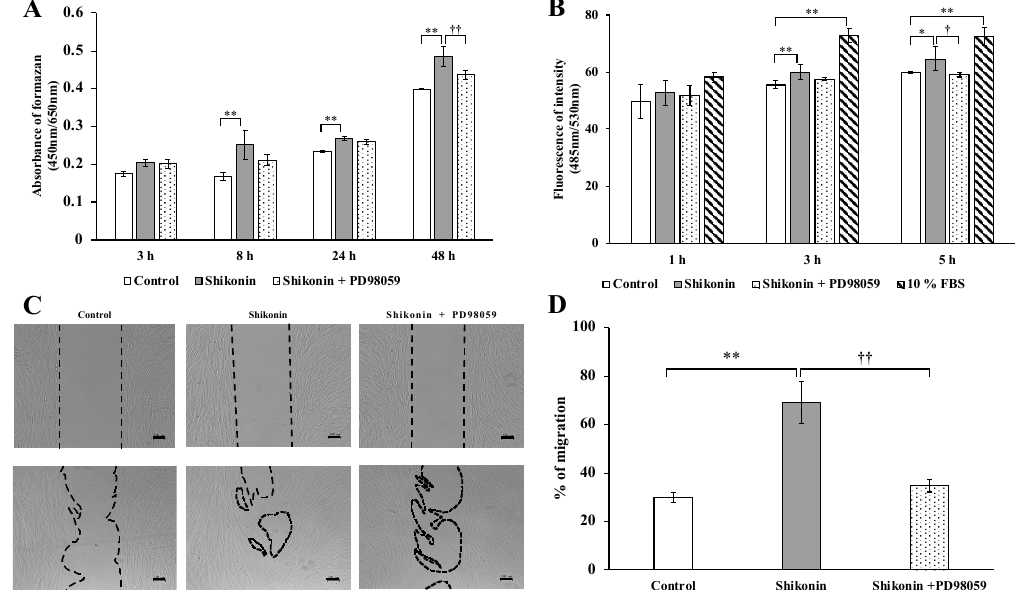
Figure 5. Effects of PD98059 on shikonin-stimulated human gingival fibroblast (hGF) cell proliferation and migration and wound repair. Treatment with 20 µ M PD98059 reduced 1 µ M shikonin-stimulated hGF ( A ) proliferation and ( B ) migration. ( C ) Images of wound repair and ( D ) quantitative data for wound repair. (* p < 0.05, control vs. 1 µ M shikonin; ** p < 0.01, control vs. 1 µ M shikonin; † p < 0.05, 1 µ M shikonin vs. 1 µ M shikonin + 20 µ M PD98059; †† p < 0.01, 1 µ M shikonin vs. 1 µ M shikonin + 20 µ M PD98059). In the cell-migration assay, 10% fetal bovine serum was used as a positive control.